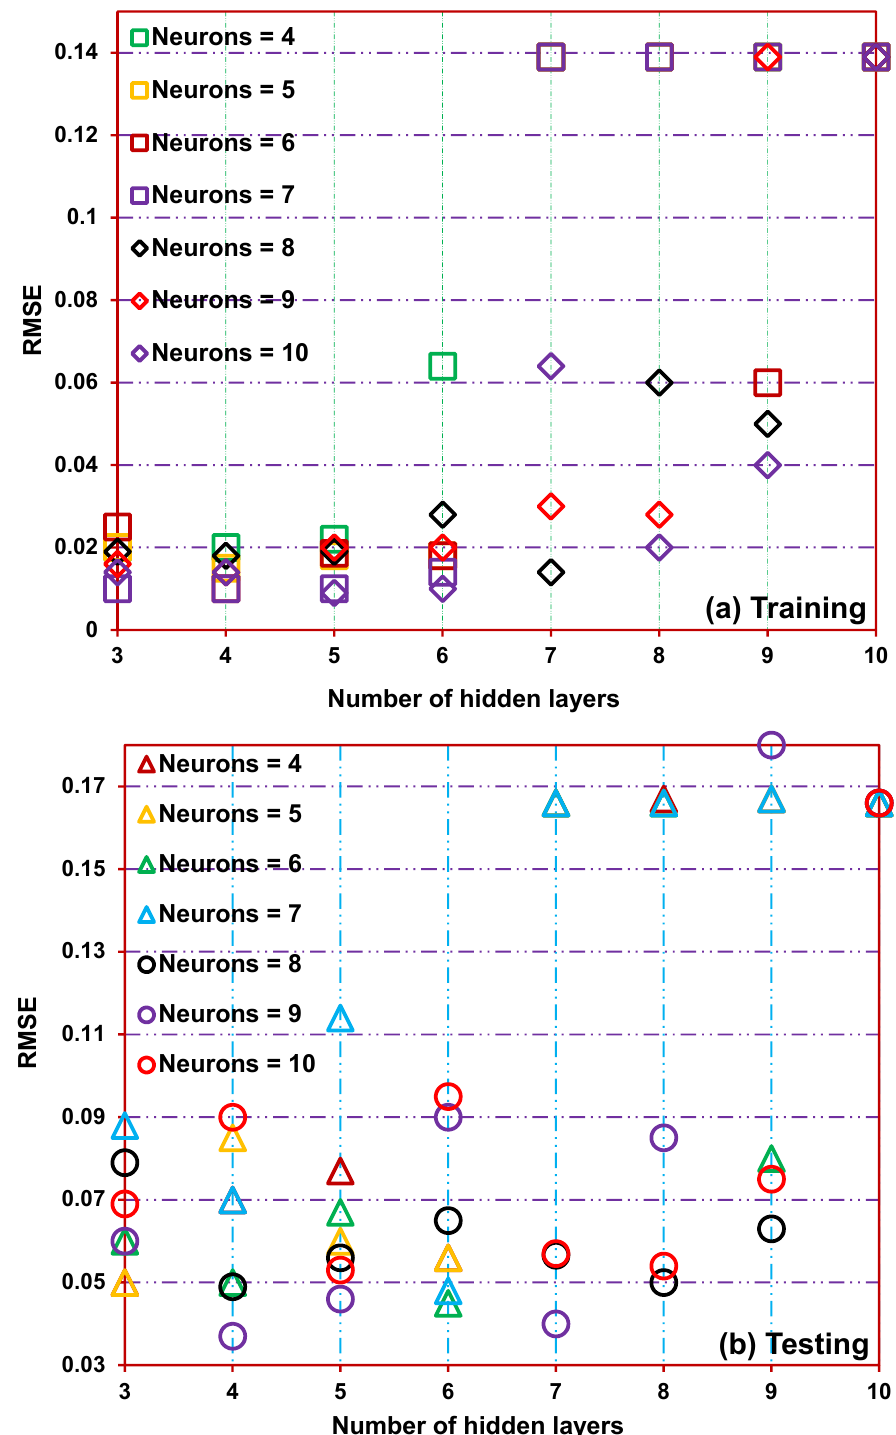
Figure 10. RMSE for the different number of neurons in each hidden layer. The number of hidden layers in deep NN are analyzed from three to 10 to get the optimized model during ( a ) training and ( b ) testing.